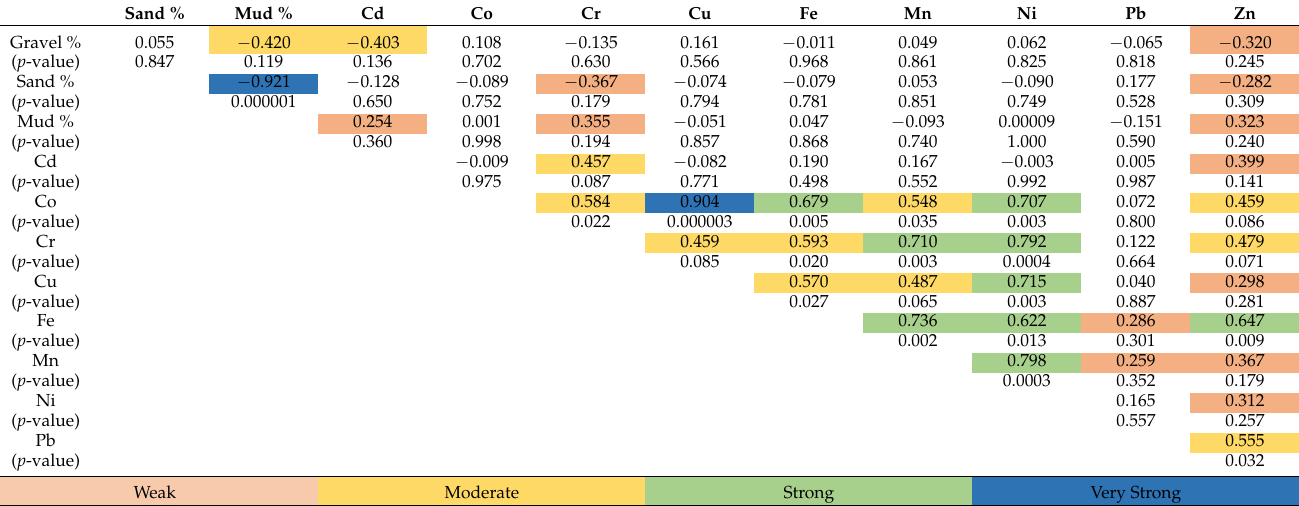
Table 5. Pearson’s correlation coefficient for all variables ( n =